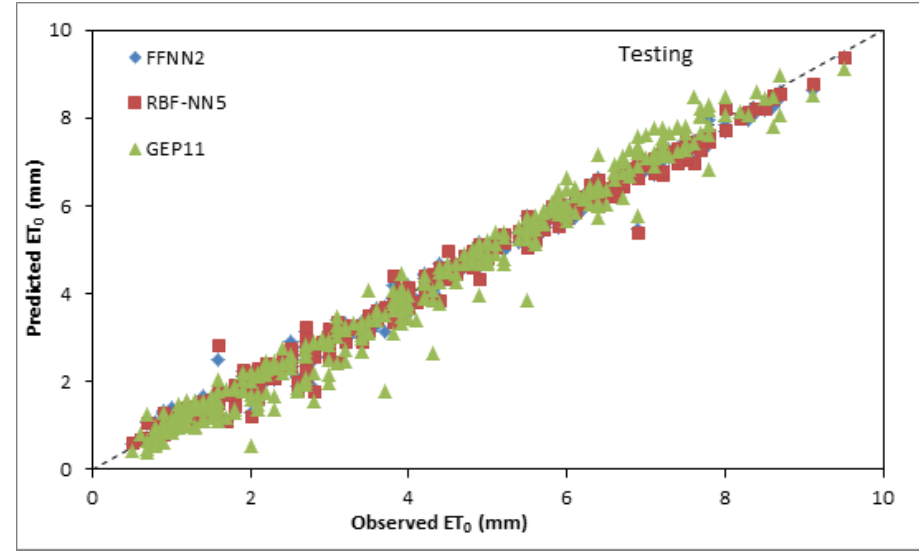
Figure 8. Scatter plot among observed and predicted values using best input combination-based models using testing data set.